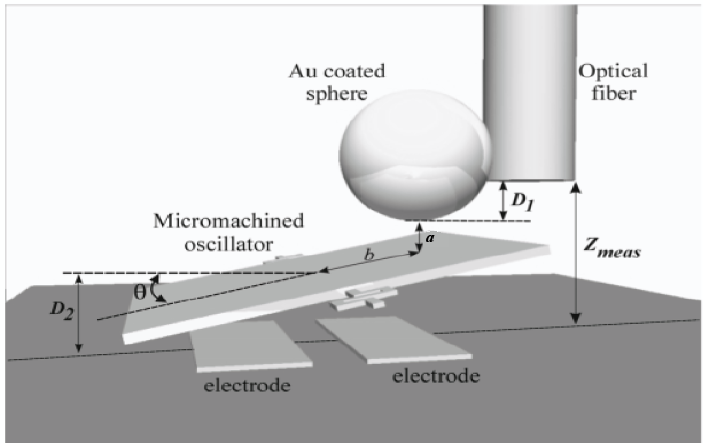
Figure 5. Schematic diagram of the experimental setup using a micromechanical oscillator for determination of the effective Casimir pressure between two parallel plates (see the text for further